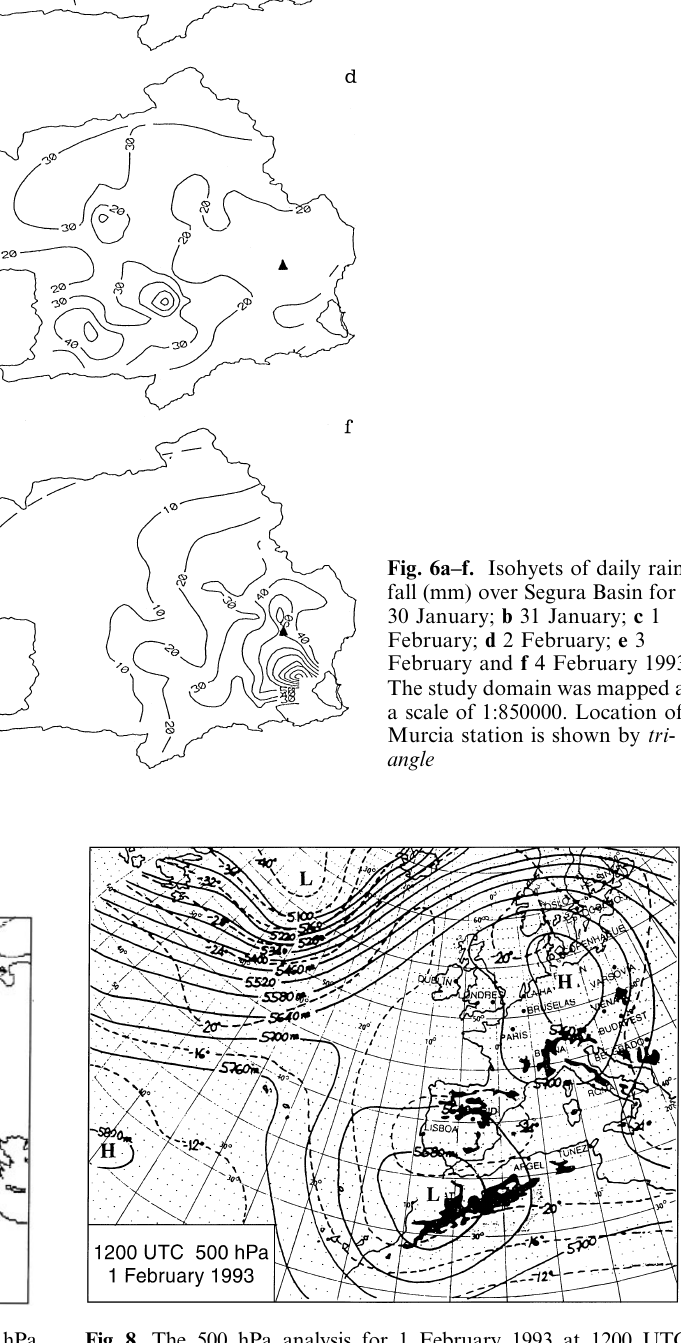
Fig. 7. Three-day back-trajectories on 1000 hPa ( solid line ), 850 hPa ( dashed line ) and 500 hPa ( dashed-dotted line ) pressure levels at Murcia station up to 31 January 1993